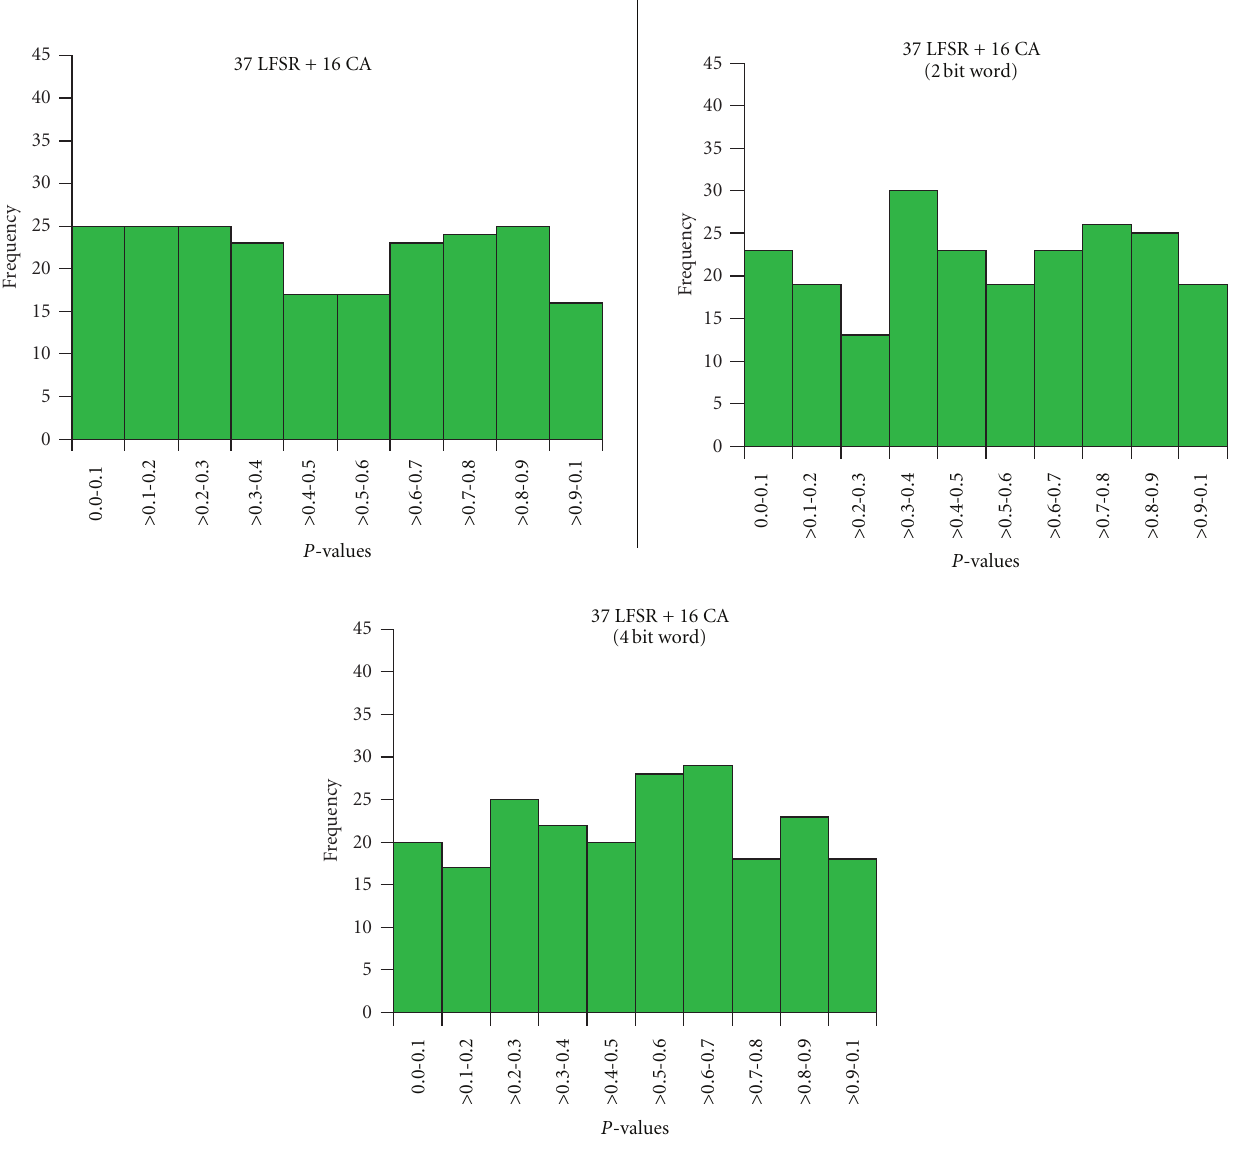
Figure 10: P -value distributions for the hybrid 37LFSR + 16CA with 2 and 4 bit outputs per time step. The previous result for the single bit version is listed again on the left for